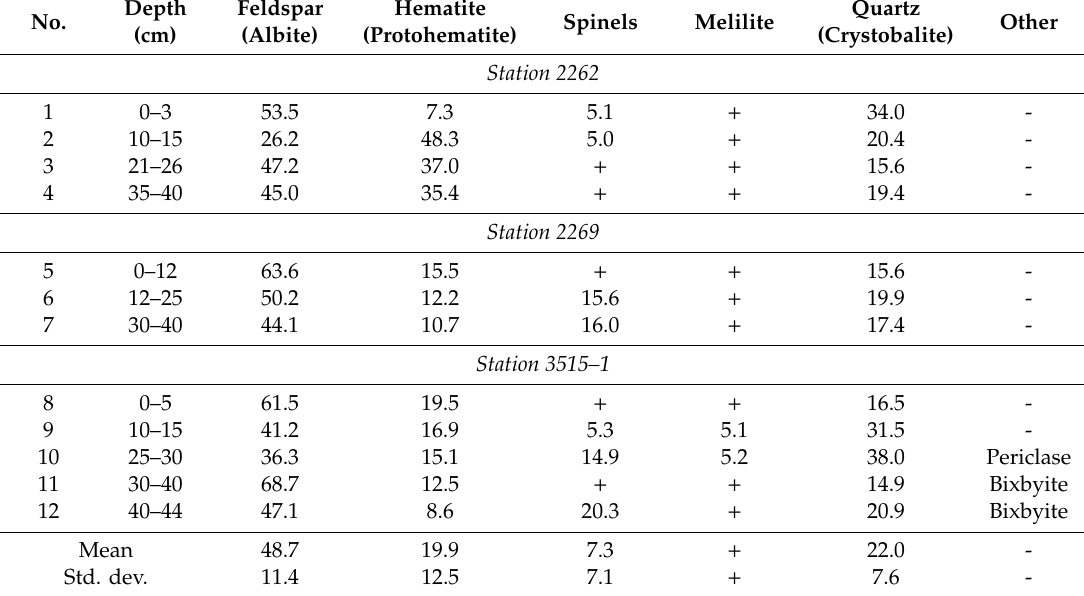
Table 8. The XRD data of heated samples (1000 ◦ C) of pelagic sediments from the CCFZ, IOM claim area ( n = 12). The amount of synthetic phases was calculated using the Rietveld method. The “ + ” signs indicate contents <